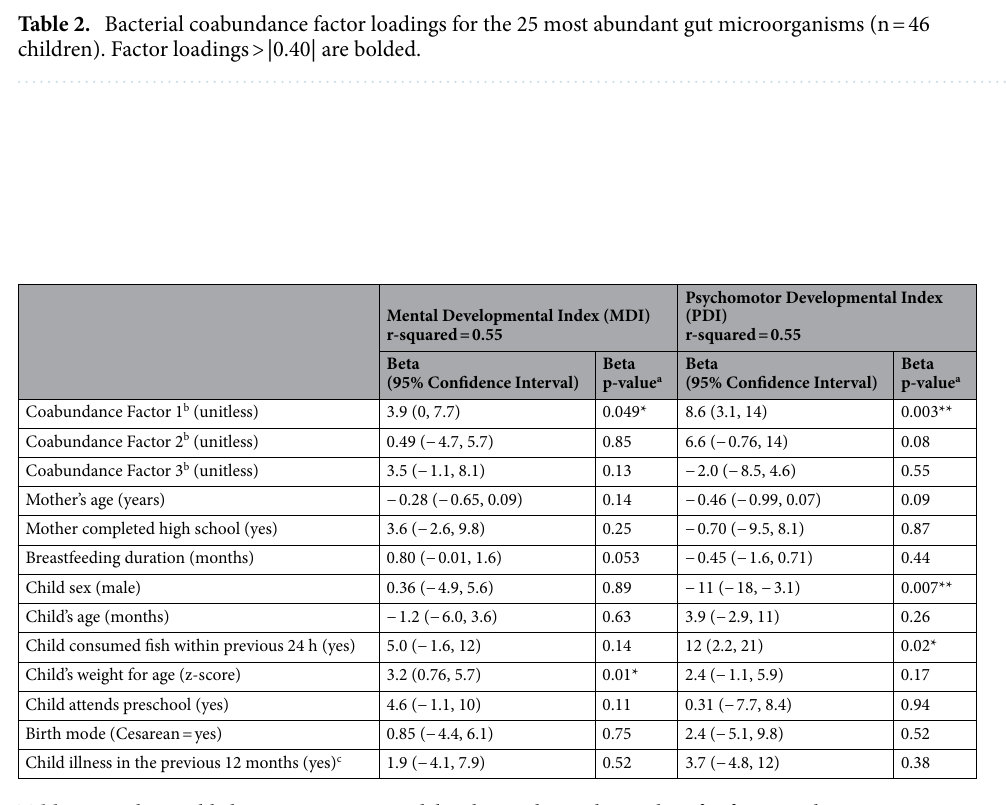
Table 3. Multivariable linear regression models relating the Bayley Scales of Infant Development-II to children’s gut microbiota coabundance factors (n = 46 children). a P-values are for the Beta coefficient: *p ≤ 0.05, **p < 0.01. b For coabundance factors 1, 2, and 3, beta coefficients and 95% confidence intervals were multiplied by the interquartile range, of 2251, 3256, and 2516, respectively. c Illnesses or symptoms included upper respiratory illness, lower respiratory illness, diarrhea, vomiting, or